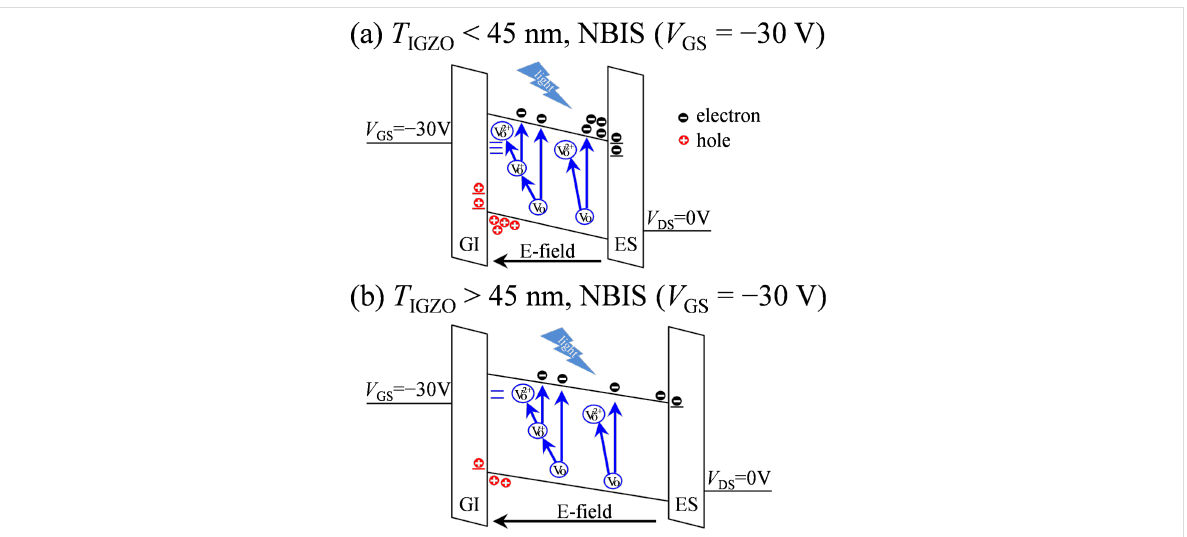
Figure 5: C − V curves before and after the NBIS duration of 10 4 s with (a) T IGZO = 25, (b) 45, (c) 75, and (d) 100 nm, respectively.